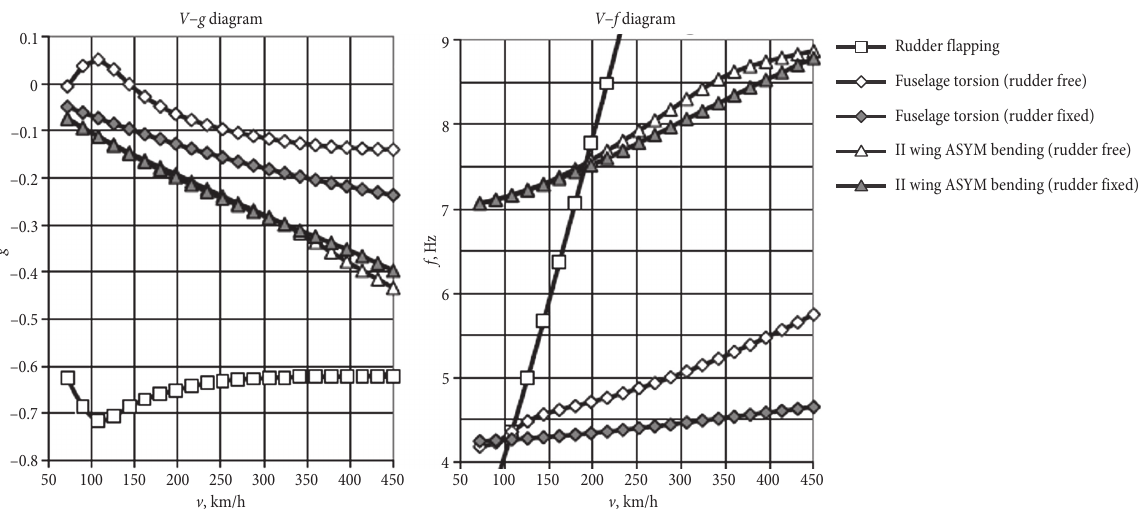
Fig. 7. V – g and V – f diagrams of sailplane LAK-17B with 15 m wing span